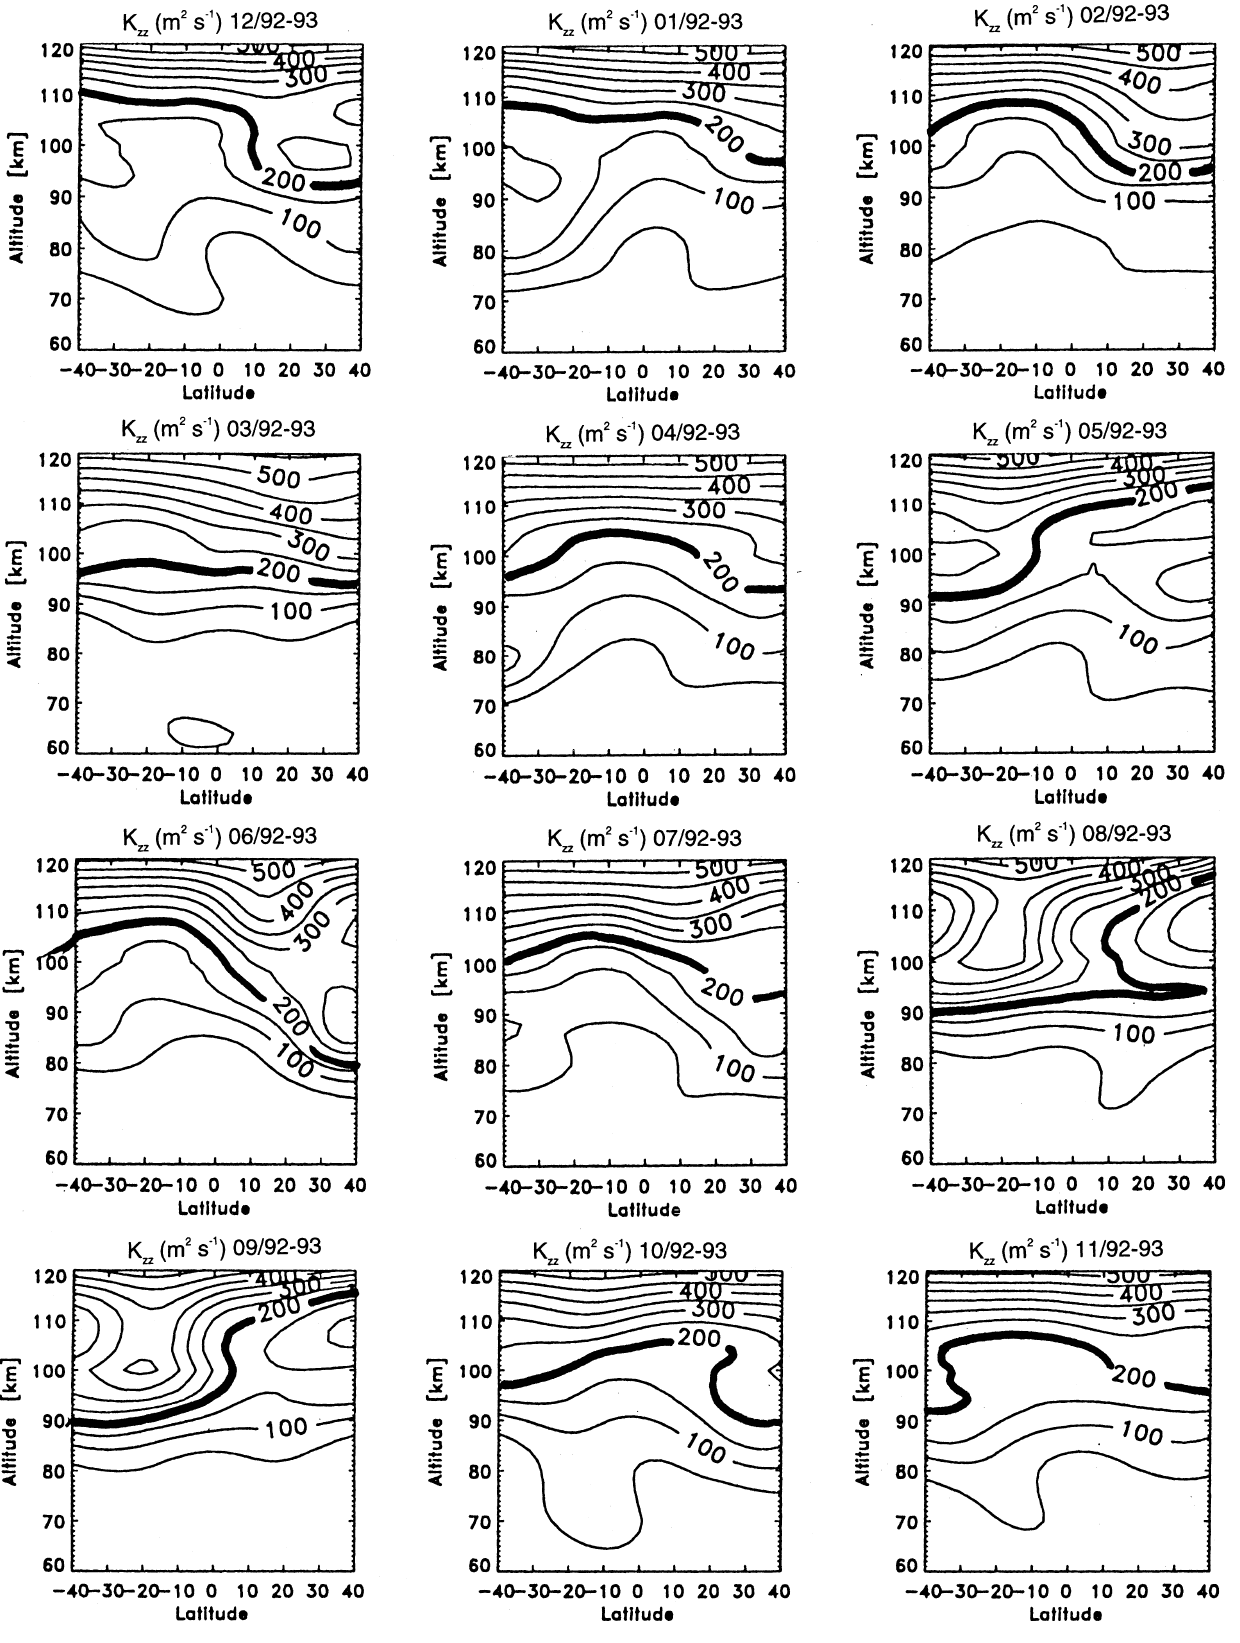
Fig. 4. Monthly mean vertical turbulent di(cid:128)usion coe(cid:129)cients inferred from HRDI data for 1992–1993 by Khattatov et al